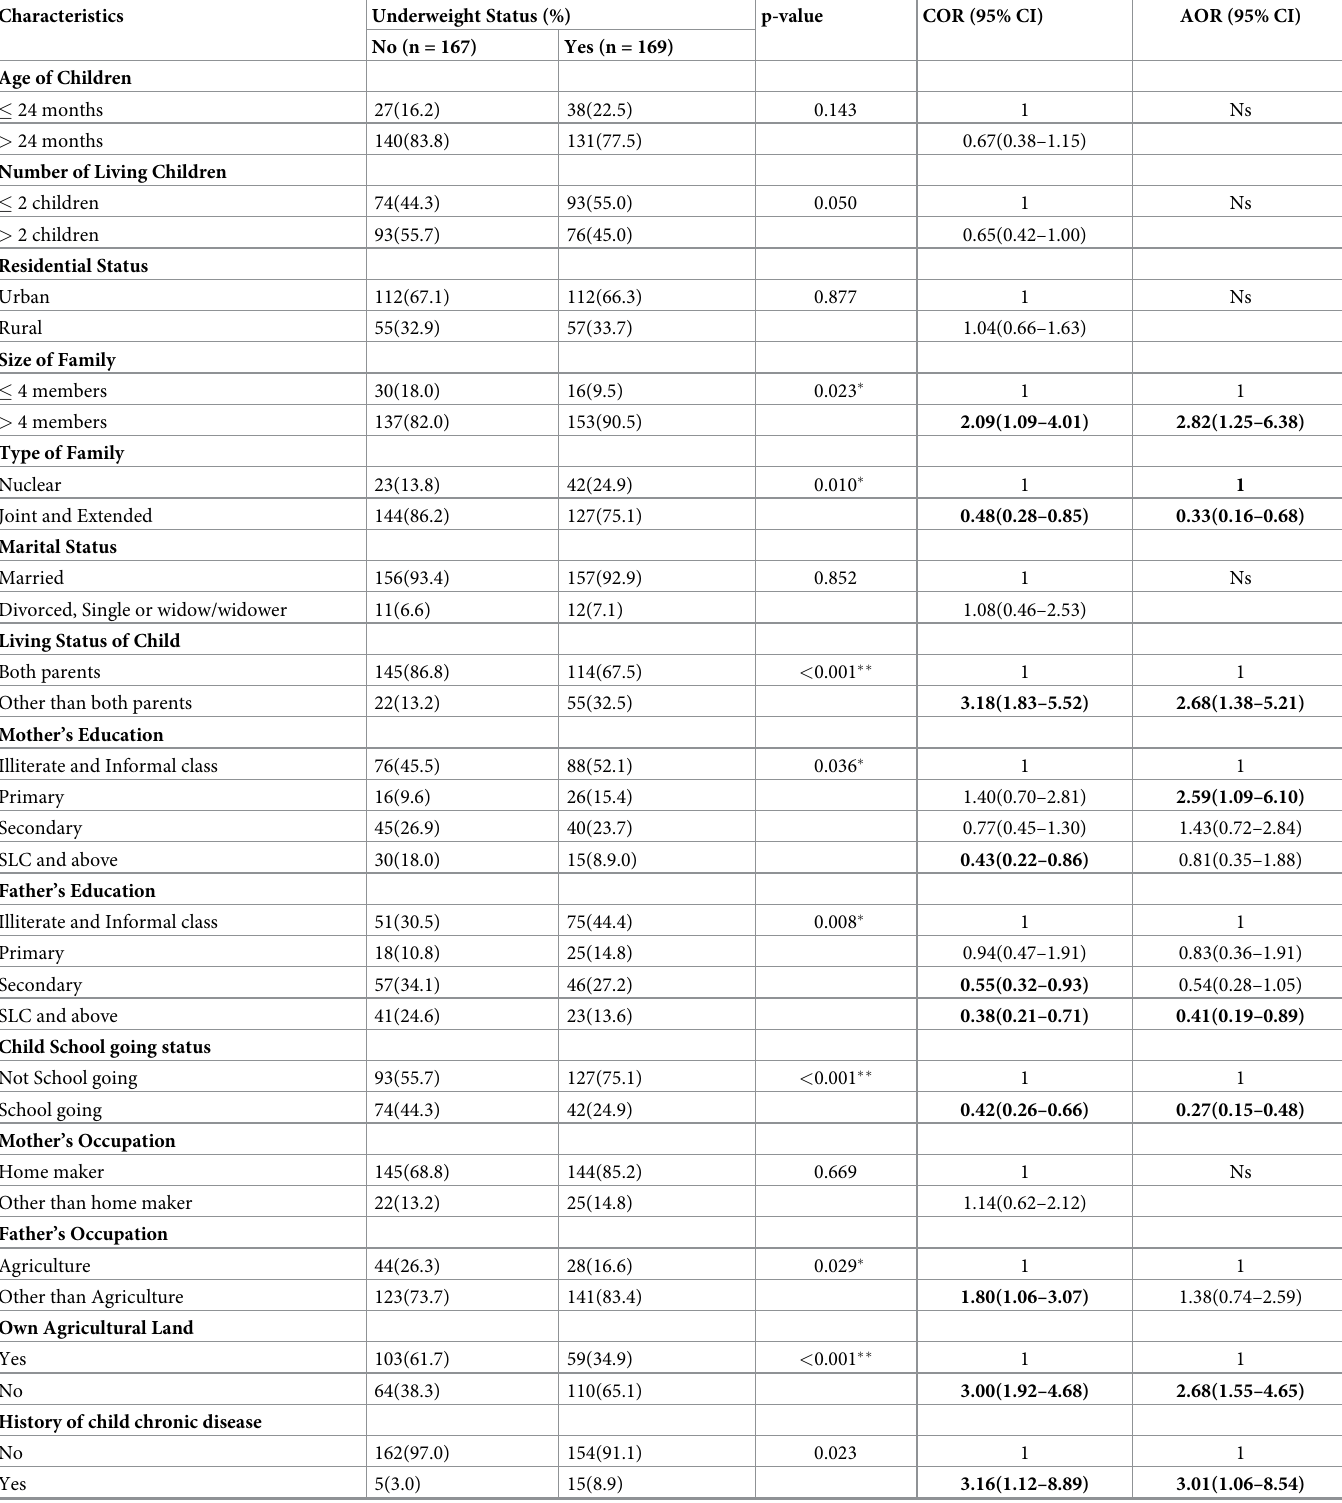
Table 4. Factors associated with underweight in using bivariate and multivariate regression model.